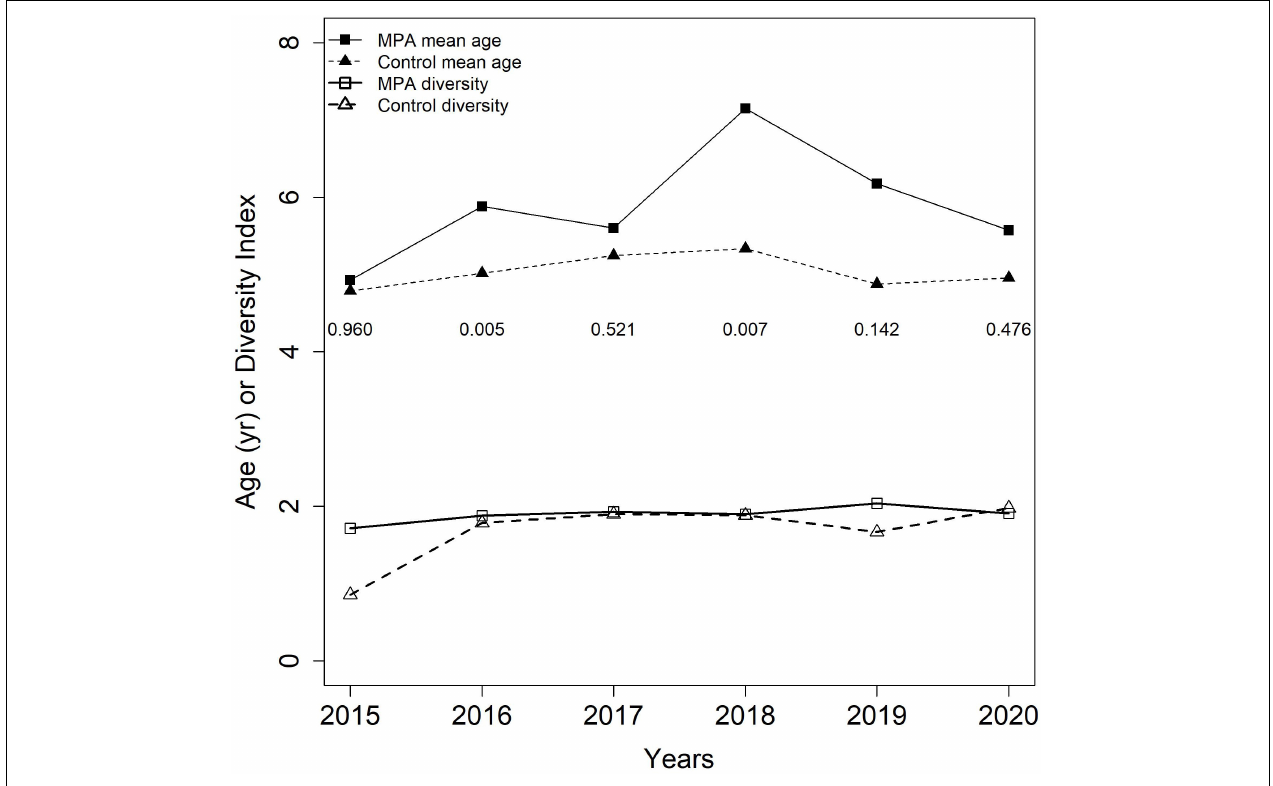
FIGURE 5 | Mean age and Shannon age diversity for red porgy caught in the Snowy Wreck Marine Protected Area and adjacent control area from 2015 to 2020 by our survey or the Southeast Reef Fish Survey. Numbers displayed below mean ages are p -values resulting from annual between-area Wilcoxon rank sum